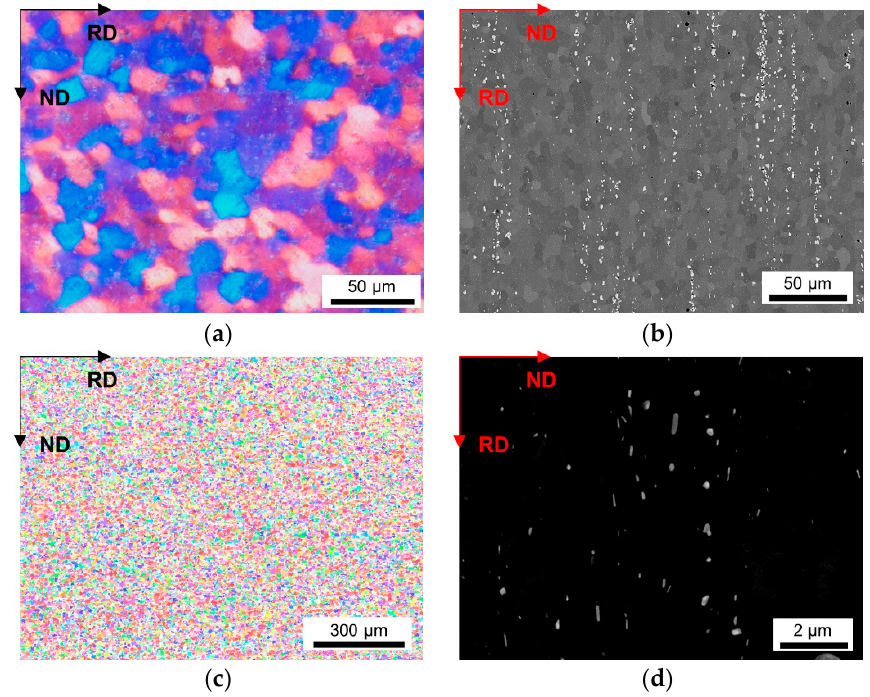
Figure A27. Microstructure of the soft annealed HFe-HMn cast under NR-C conditions, homogenized at 550 °C and cold rolled to a CRD of 63%. ( a ) LOM. ( b ) BSE image. ( c ) EBSD IPF map in RD–ND plane. ( d ) BSE micrograph showing dispersoids.